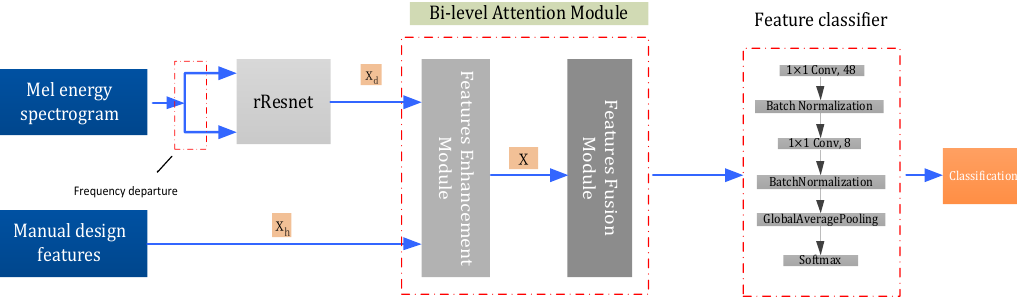
Figure 5. MFF-ResNet. The inputs of MFF-ResNet are log-Mel spectrogram features and manual design features. The two branch outputs of the spectrogram features were used for frequency fusion with rResNet (as shown in Figure 6). The more abstract features are obtained by the bi-level attention module, which includes a features enhancement and a fusion module (as shown in Figures 7 and 8, respectively). The fused features are then passed through the feature classifier to produce the final classification